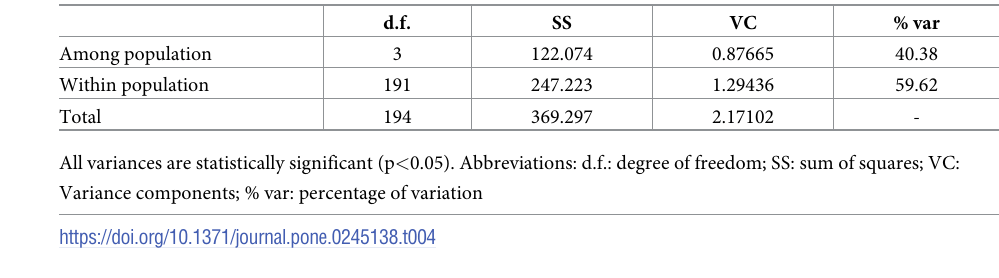
PLOS ONE | https://doi.org/10.1371/journal.pone.0245138 February 9,